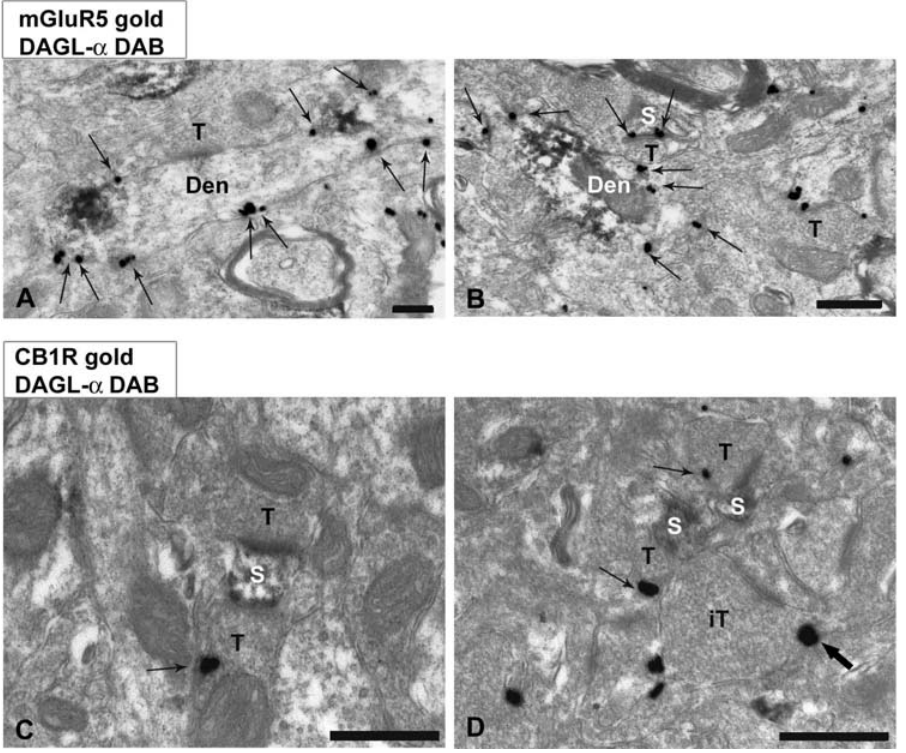
Figure 2. Immunocytochemical localization of mGluR5/DGL- a (A, B) and CB1R/ DGL- a (C, D) in mouse prPFC cortical layers V/VI. Double preembedding immunogold and immunoperoxidase methods for electron microscopy. (A, B) mGluR5 metal particles (arrows) and DGL- a immunodeposits colocalized in postsynaptic dendrites (den) and dendritic spines (s). mGluR5 labeling was in perisynaptic and extrasynaptic membranes. No mGluR5/DGL- a immunoreactivity was observed in presynaptic terminals (T). (C, D) CB1R immunoparticles were on presynaptic terminals membranes (T) away from synaptic specializations made on postsynaptic DGL- a -immunoreactive dendritic spines (s). Observe that DGL- a - positive spines also received CB1R-immunonegative synaptic terminals, and that a CB1R-labeled presynaptic terminal (thick arrow) probably of inhibitory nature (IT in D) made a synapse with a postsynaptic DGL- a -negative dendritic branchlet. Scale bars: 0.5 m m.